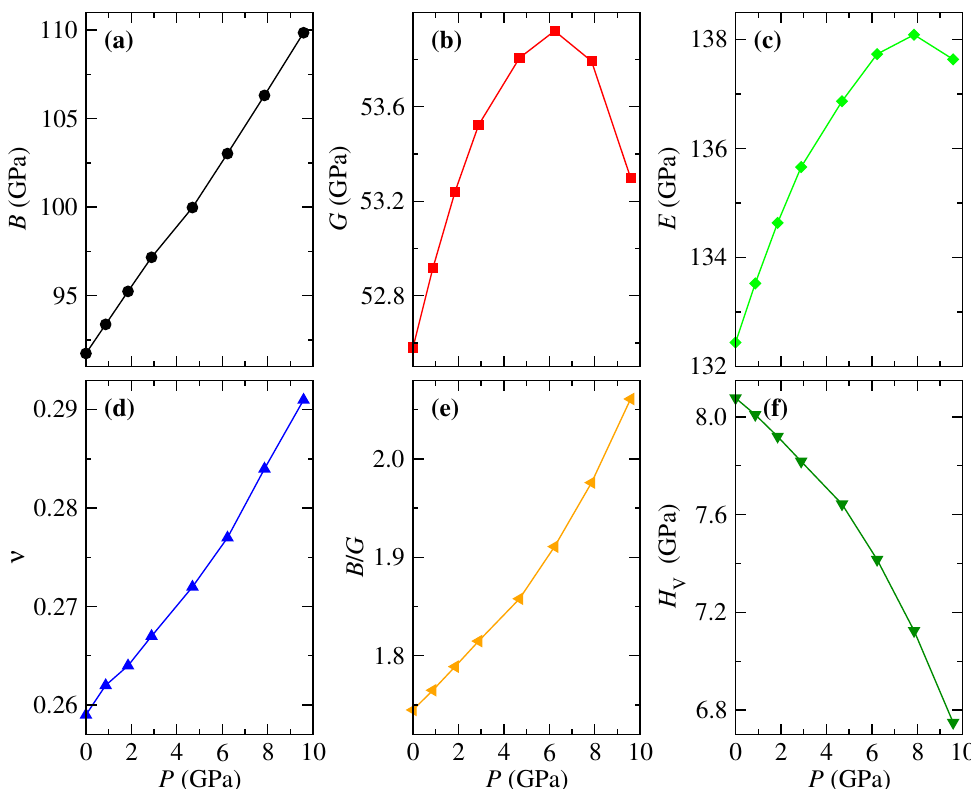
Figure 5. Pressure dependence of mechanical properties obtained from elastic constants with the Hill average: ( a ) bulk modulus, B , ( b ) shear modulus, G , ( c ) Young’s modulus, E , ( d ) Poisson’s ratio, ν , ( e ) Pugh’s ratio, B / G , and ( f ) Vickers hardness, H V , for FeVO 4 - II